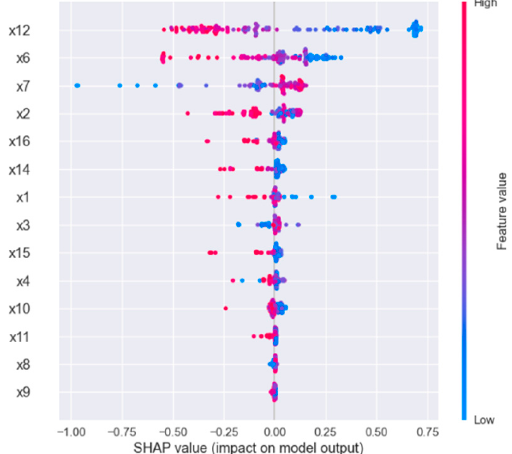
Figure 9. SHAP value of each feature for each sample.